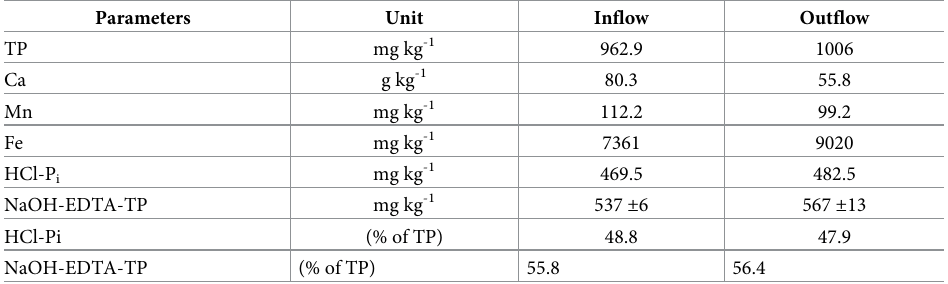
Table 1. Sediment metal content. Characterization of inflow and outflow sediment samples from ditch 3.